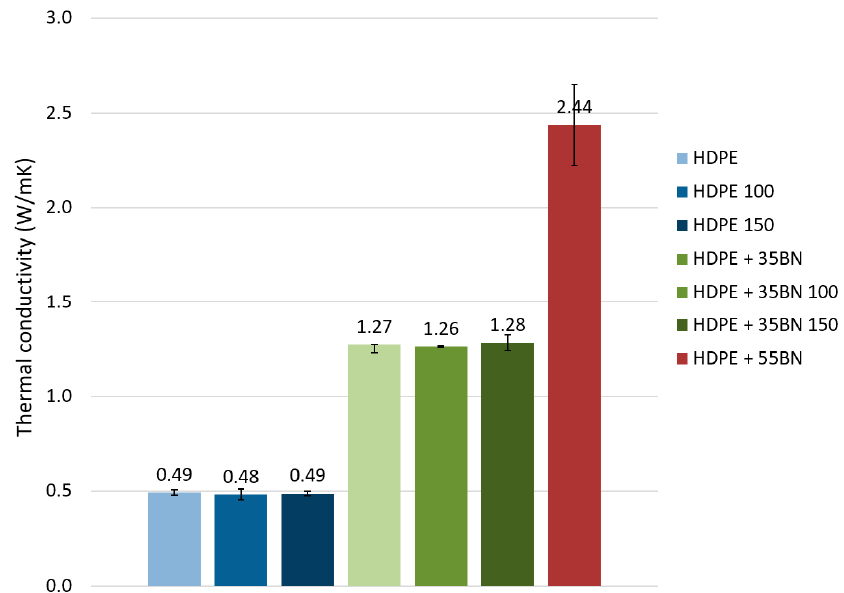
Figure 5. Thermal conductivity values measured perpendicularly to injection molding direction for samples with different content of the BN filler: 0, 35, and 55 wt.%. Results are shown for reference pristine samples and samples after testing shape memory effect. Bars with standard deviation are indicated for each type of specimen. See Table 1 for samples definition.